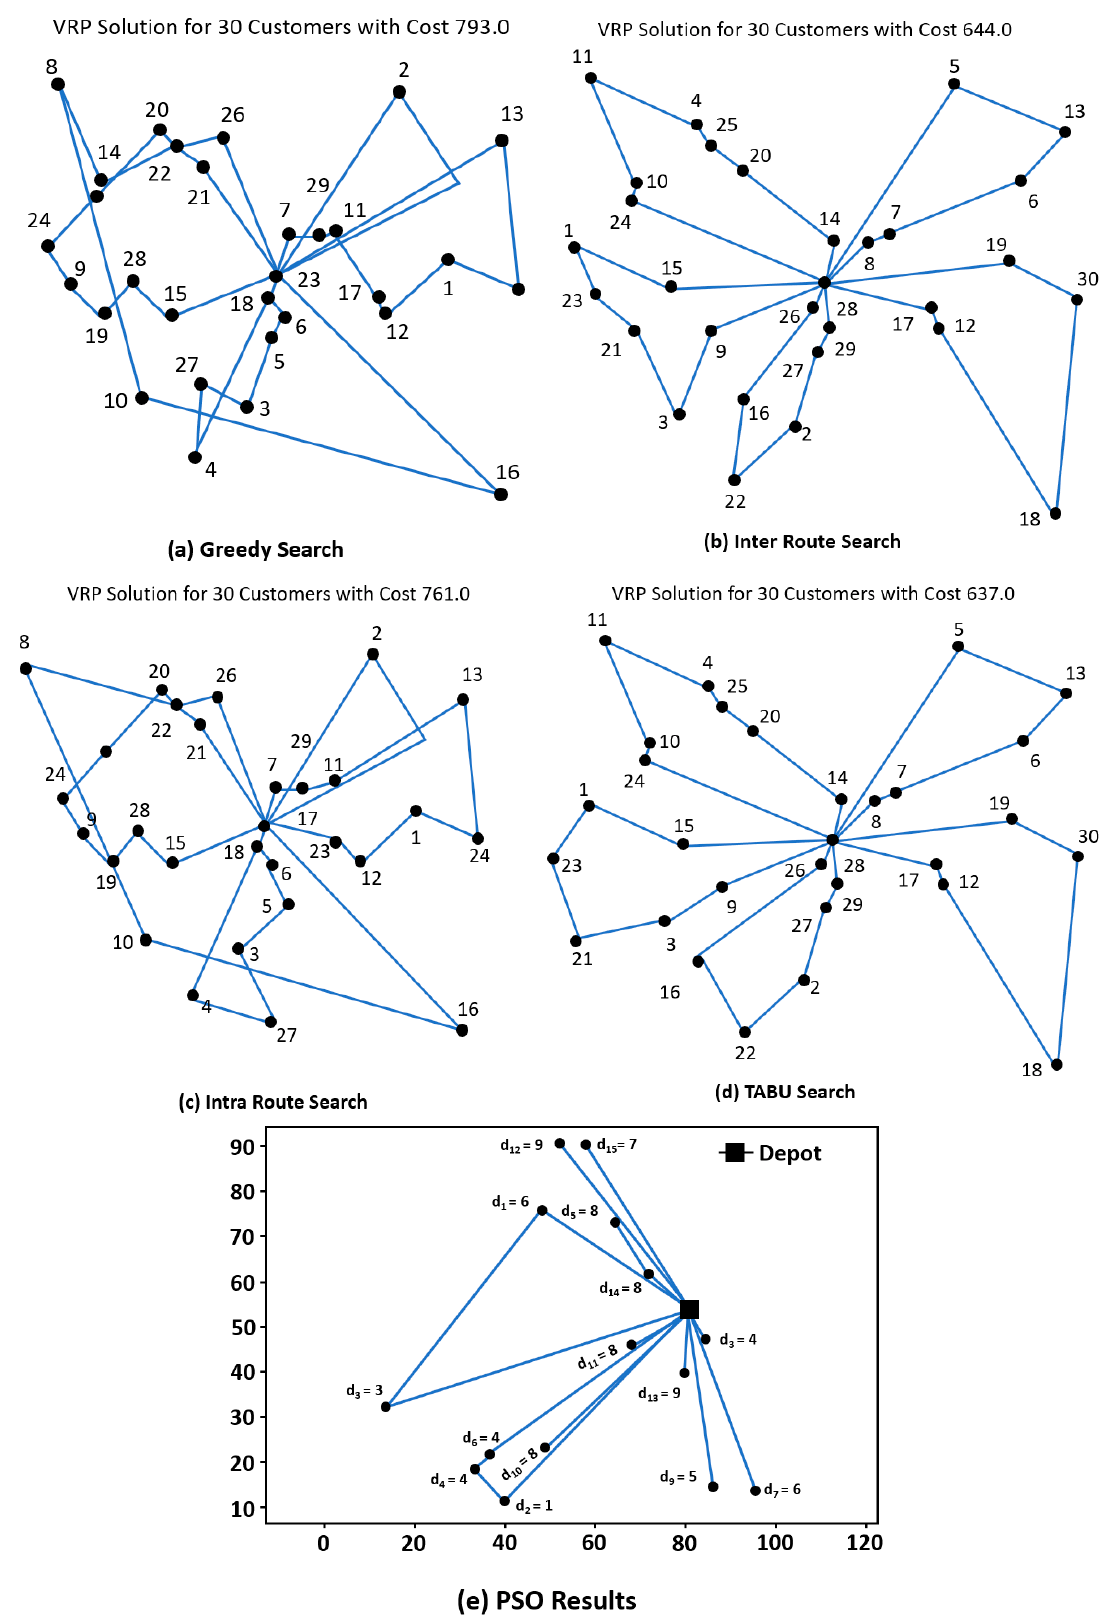
Figure 15. Results of the route optimization algorithms for 10 UAVs, 30 victims, and 50 units of capacity ( a ) Greedy search, ( b ) Inter route search, ( c ) Intra route search, ( d ) Tabu Search, ( e ) PSO